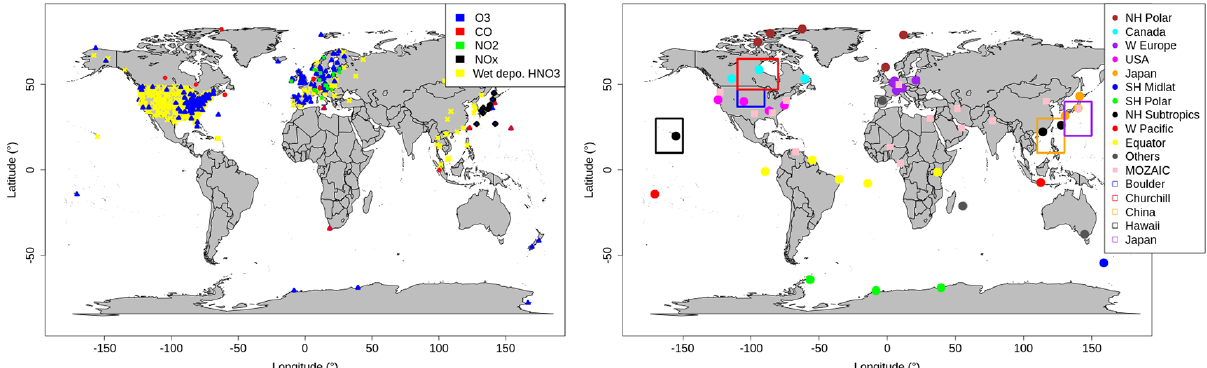
Figure 1. Stations used for the evaluation of the NMMB-MONARCH model. On the left, surface-monitoring rural stations of O 3 (blue triangle), CO (red circle), NO 2 (green square cross) and NO x (black diamond) are shown. Moreover, wet deposition of HNO 3 measurement locations (yellow cross) is presented. On the right, locations of the ozonesondes used are shown. Ozonesondes are grouped by the following regions: NH Polar (brown circle), Canada (cyan circle), W Europe (purple circle), US (pink circle), Japan (orange circle), SH Midlat (blue circle), SH Polar (green circle), NH Subtropics (black circle), W Pacific (red circle), Equator (yellow circle) and Others (gray circle). In addition, CO vertical profiles from the MOZAIC aircraft campaign (pink square) are presented. Finally, large rectangles show areas for the climatology analysis (NO x , PAN and HNO 3 ) for Boulder (blue), Churchill (red), China (orange), Hawaii (black) and Japan